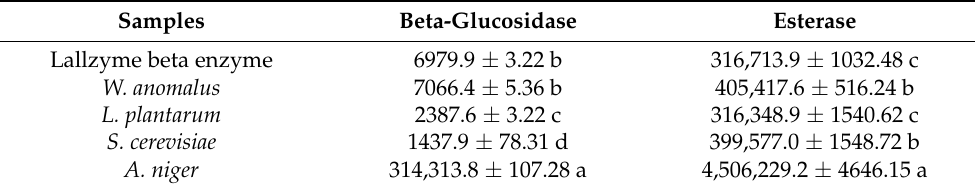
Table 3. Beta-glucosidase and esterase activities detected for the commercial enzyme and the different microorganisms tested under their specific growth culture